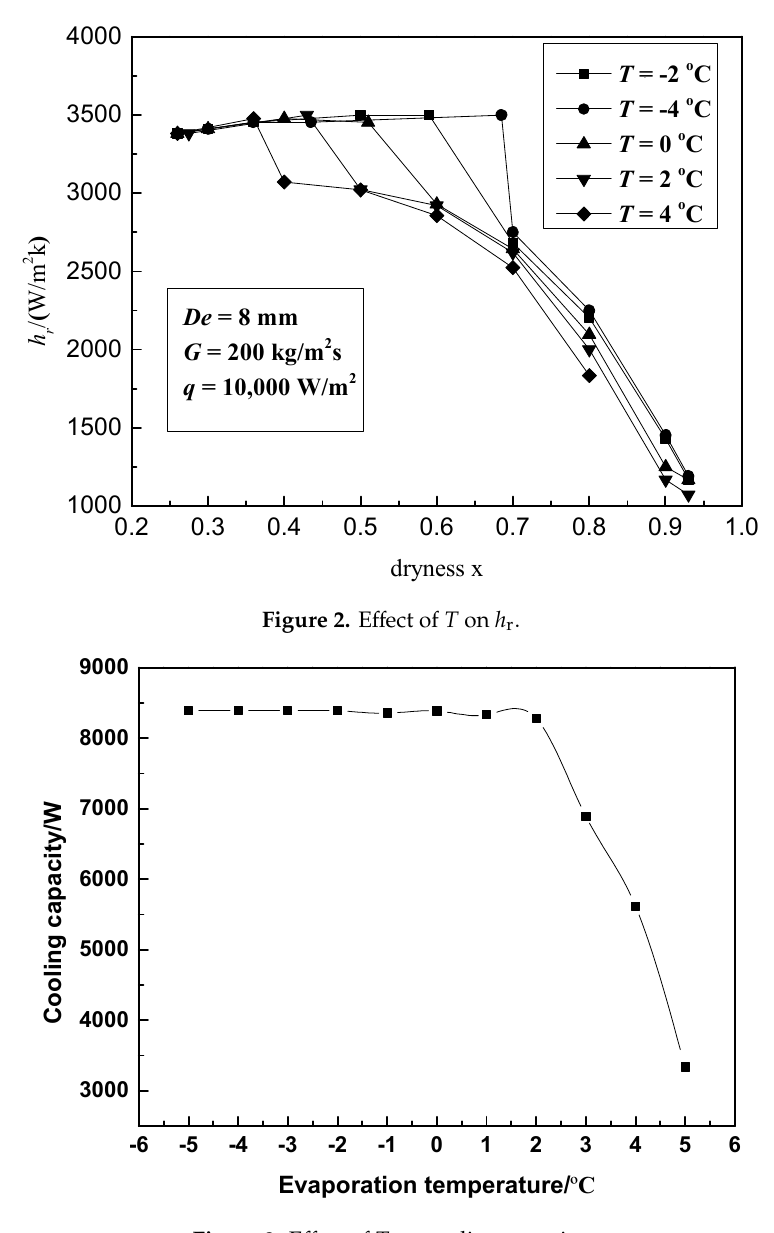
Figure 3. Effect of T on cooling capacity.